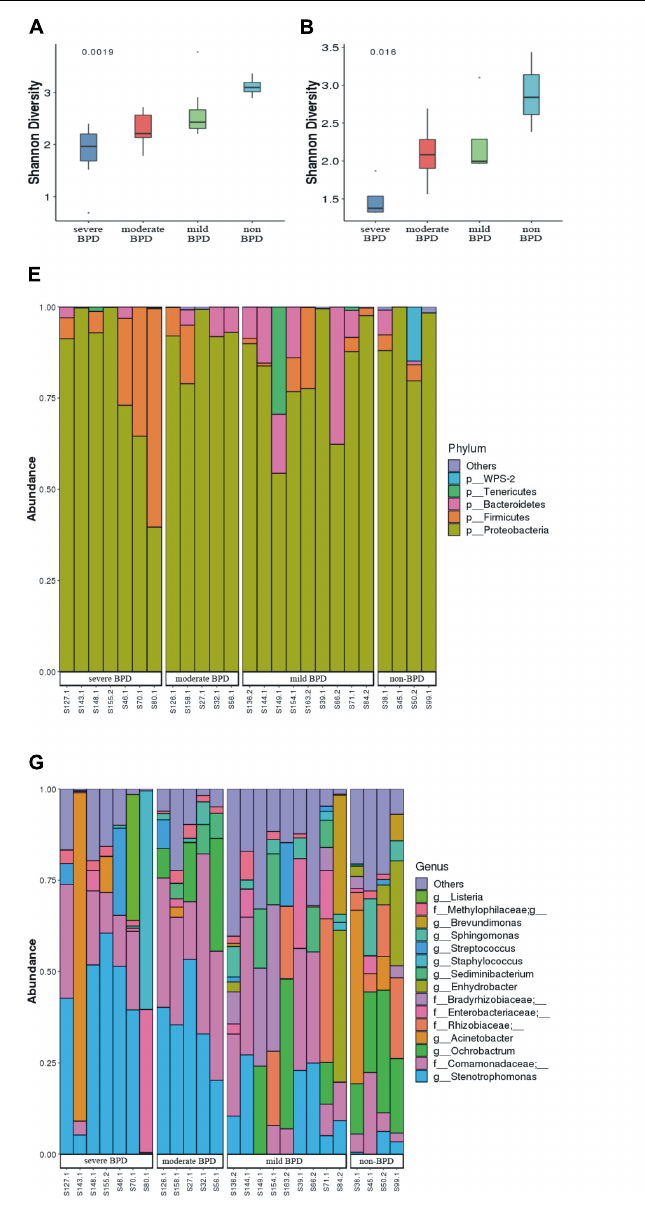
FIGURE 1 | Diversity and composition of the airway microbiome. (A) Shannon index at birth (Day 1); (B) Shannon index on Day 7 after birth (a greater Shannon index is indicative of higher microbial diversity); (C) Principal coordinate analysis (PCoA) of microbial communities at birth (Day 1); (D) PCoA of microbial communities on Day 7 after birth (samples near to each other have similar microbial composition, while samples far from each other have distinct microbial composition); (E,F) Relative abundance of bacterial phyla ( E stands for day 1 after birth, F stands for day 7 after birth). (G,H) Relative abundance of bacterial genera ( G stands for day 1 after birth, H stands for day 7 after birth). (On day 1, the number of infants with severe BPD, moderate BPD, mild BPD and non-BPD was 7, 5, 9, and 4, respectively. On day 7, the number of babies was 4, 4, 4, and 3, respectively. On day 7, some specimens were